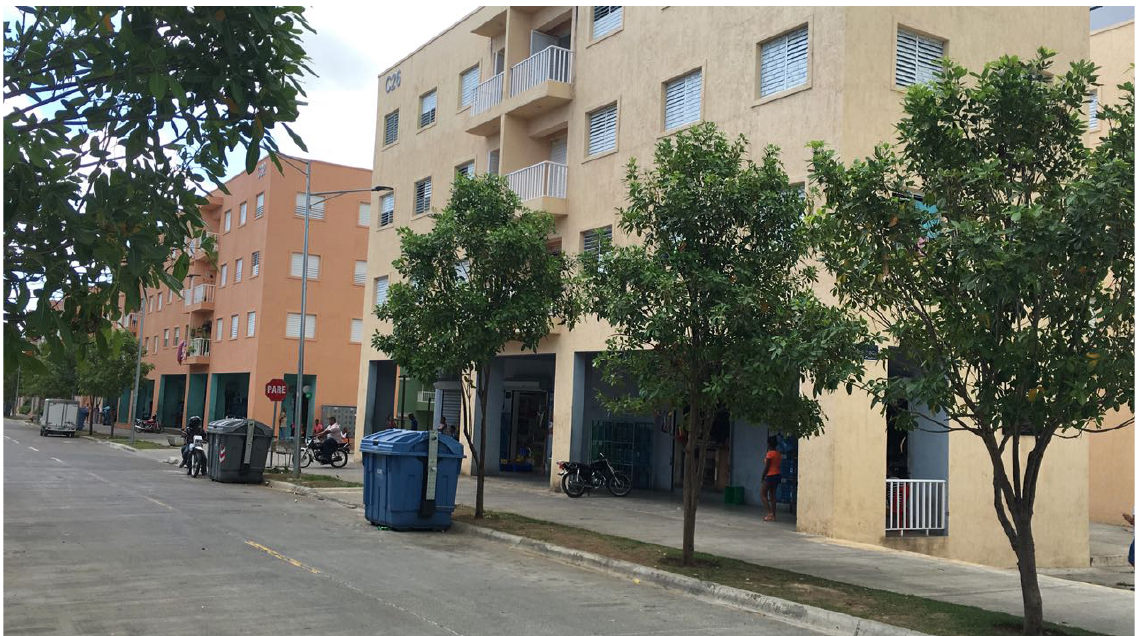
Figure 5. Integrated services in LNB: apartments, businesses, sidewalks, trash collection system, public lighting, and public signs. Source: